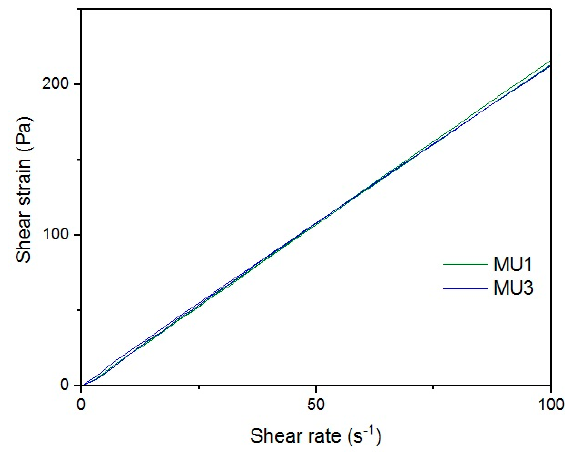
Figure 16. Magnification of the shear strain-shear rate relations for MU1 and MU3 prepolymers at CSR = 100 s − 1 .